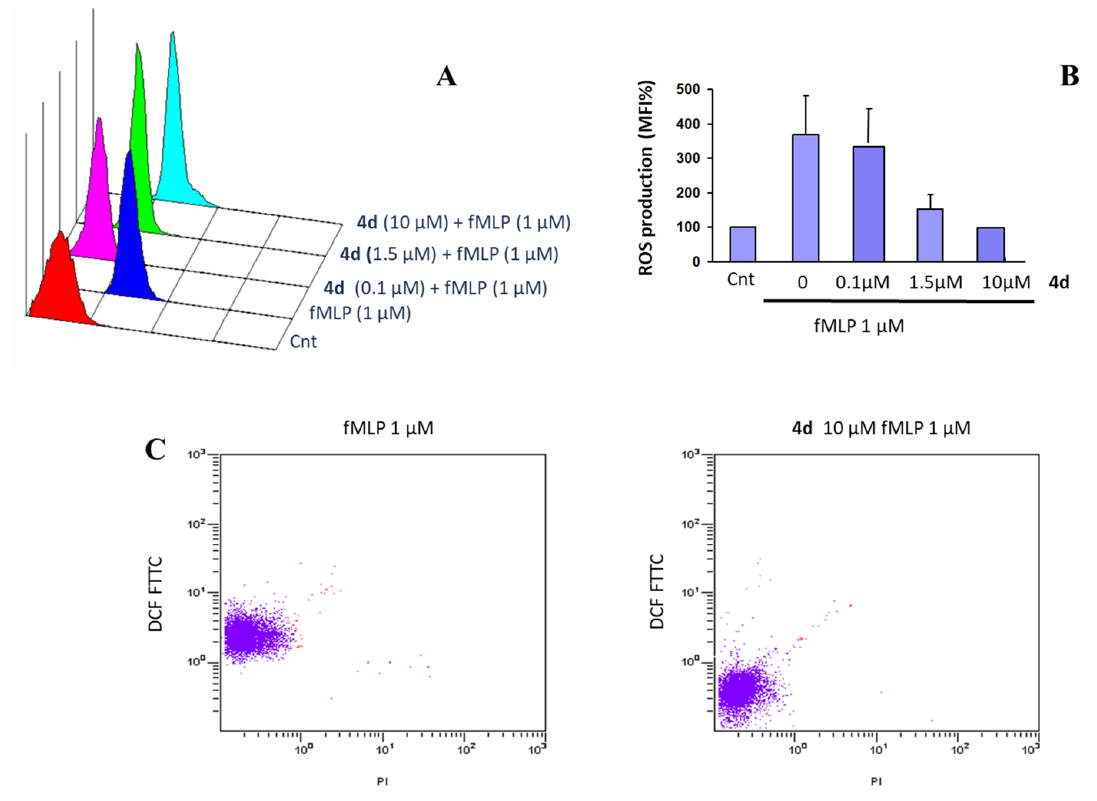
Figure 4. Modulation of neutrophil oxidative metabolism and cell vitality assessed by flow cytometric analysis in the presence of propidium iodide (PI). Representative images relative to evaluation of compound 4d in formyl-methyl-leucyl-phenylalanine (fMLP)-activated neutrophils. ( A ): reactive oxygen species (ROS) intracellular level reduction ( B ): dose-dependent effect of compound on ROS reduction ( C ): cell vitality determined by PI method. Data are expressed as mean ± SD and are representative of four separate experiments.